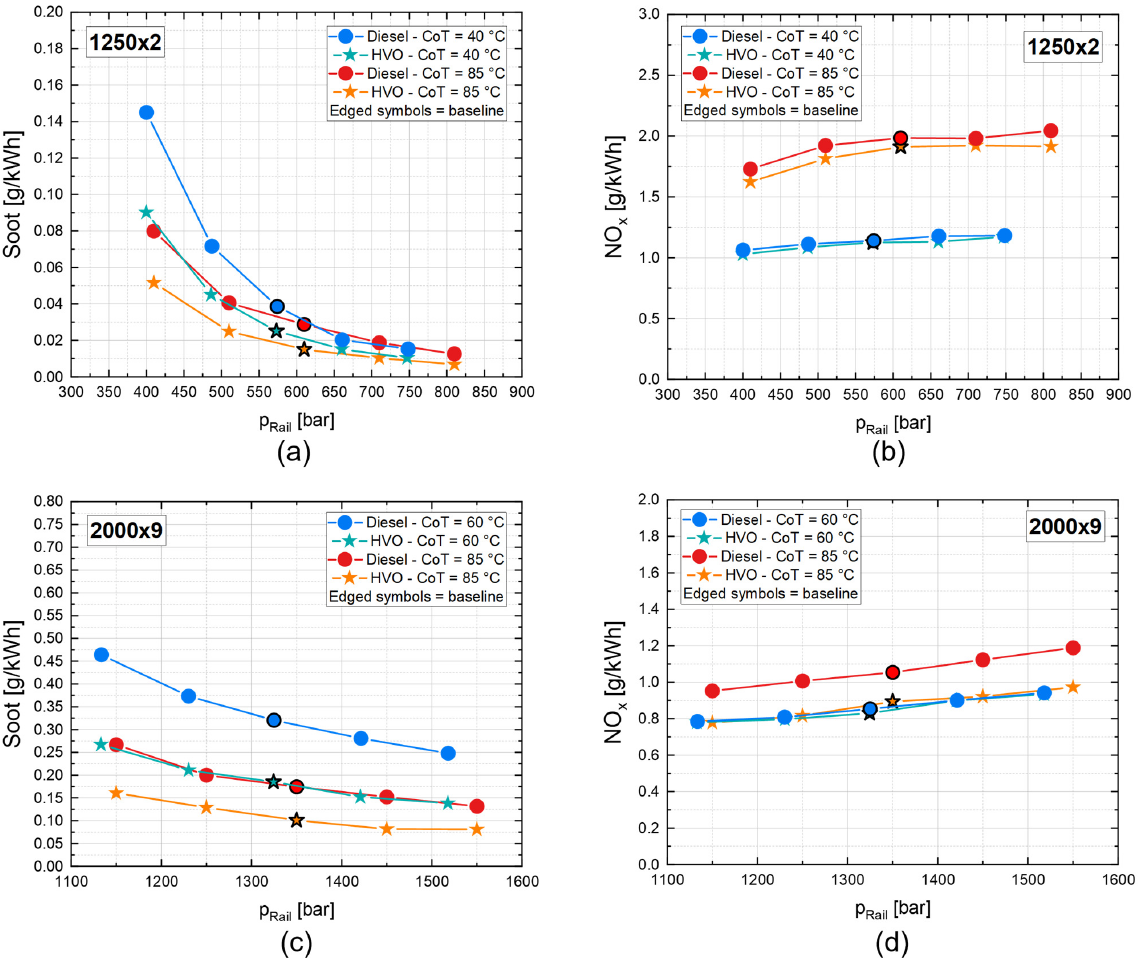
Figure 12. Soot and NO x emissions along p Rail sweep tests at 1250 × 2 ( a , b ) and 2000 × 9 ( c , d ). Comparison between diesel and HVO at high and low coolant temperatures. Warm colors represent high coolant temperatures, while cool colors represent low coolant temperatures. Circles represent diesel, while stars represent HVO.